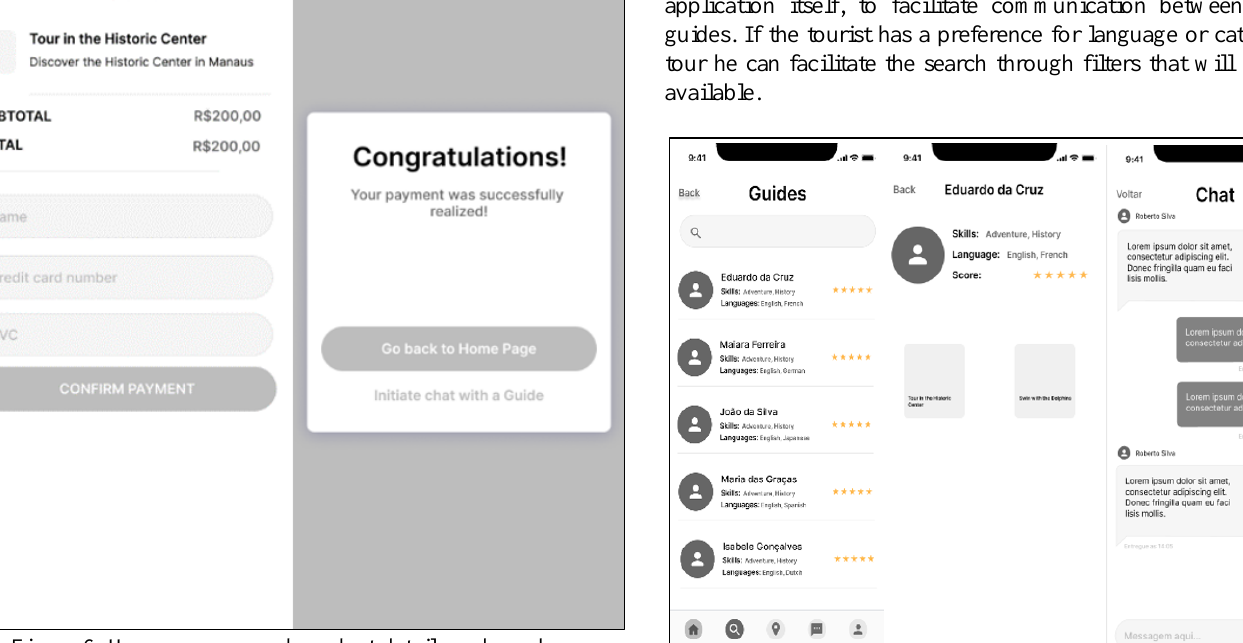
Figure 6: Home screens and product details and purchase completion.